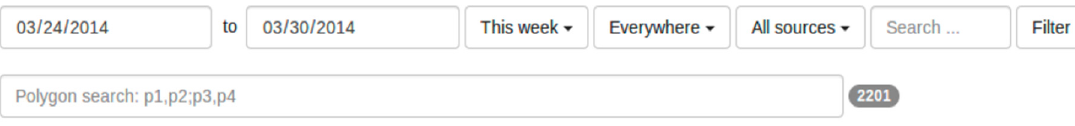
Figure 3. Geo-web interface query tool. Allows users to set custom temporal, geographic, and thematic parameters to query, display, and extract data for analysis. Possible selections include custom or pre-set date ranges, geographic regions, specific data sources, and specific keyword and phrases. Users also have the option to draw a polygon on the mapping interface and display and extract all data within the polygon.